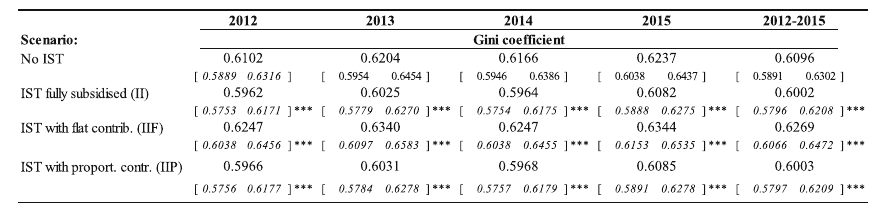
Table 3 Effects of the IST on farm income concentration. Gini coefficient without and with the simulated implementation of the IST. Years from 2012 to 2015 and whole